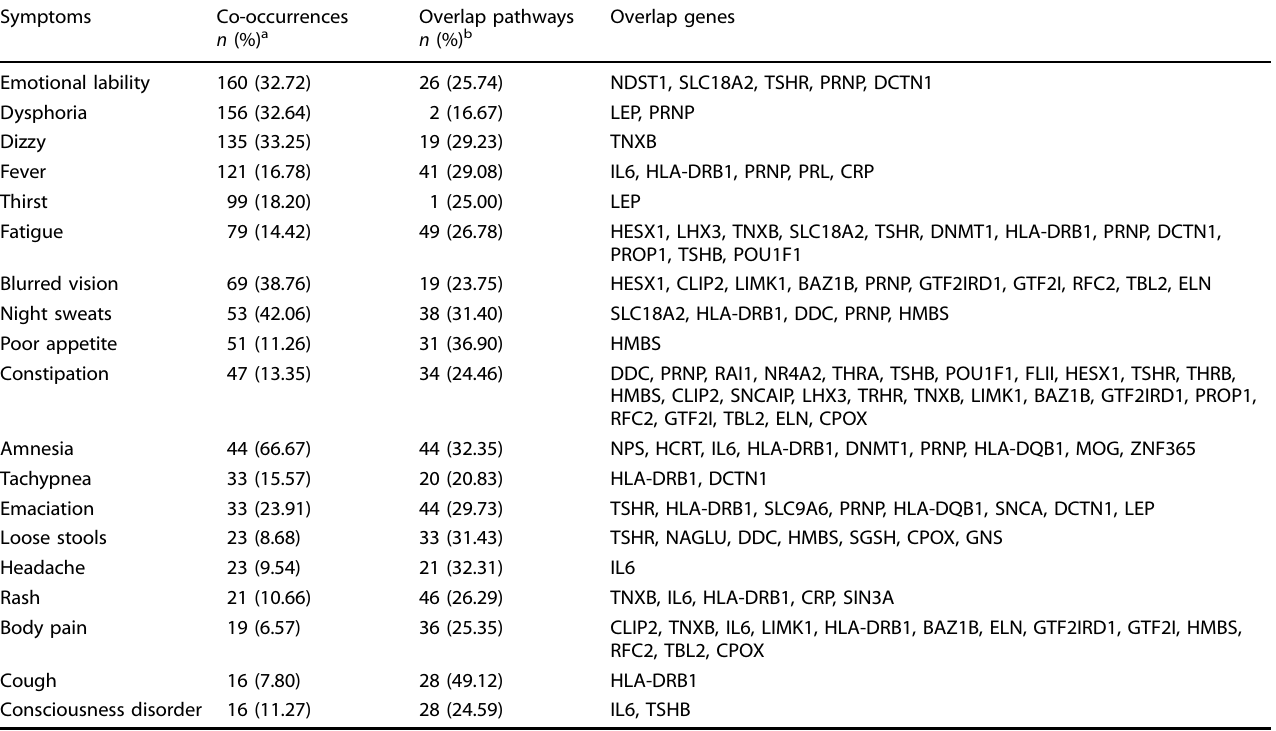
Table 3. The basic molecular features of insomnia symptom cluster (sorted by the co-occurrences).